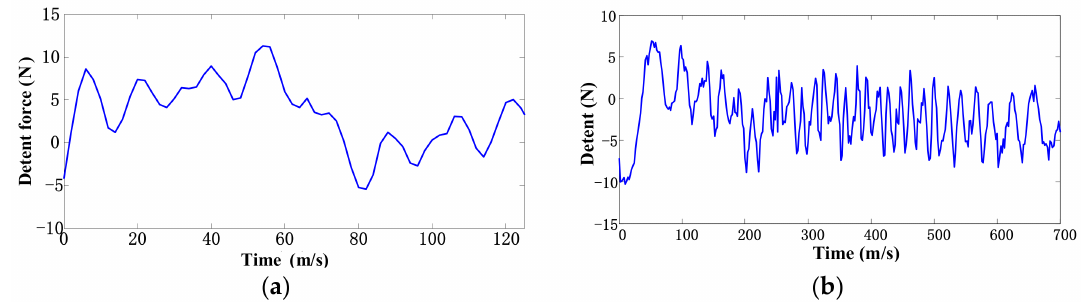
Figure 11. Detent force curves at ( a ) constant and ( b ) sine